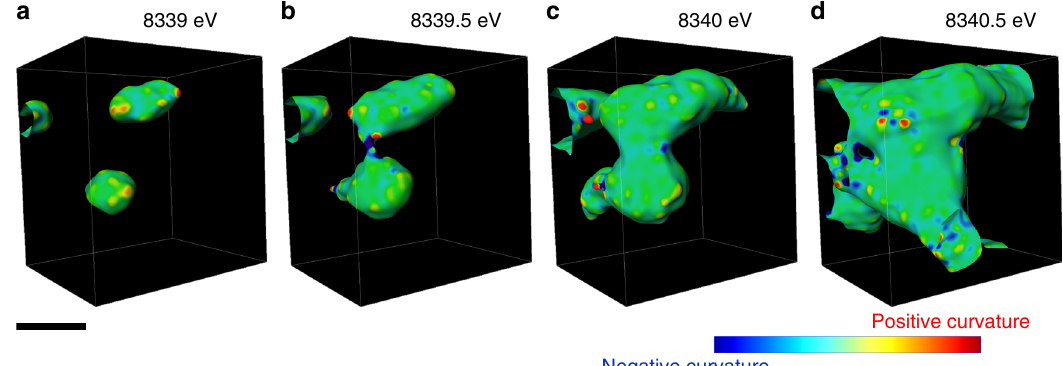
Fig. 5 Visualization of the phase front propagation at a selected localized region. The isosurface develops as thresholding Ni K-edge energy value is changed: a 8339 eV, b 8339.5 eV, c 8340 eV, and d 8340.5 eV. The evolution of the isosurface shows the propagation of the reaction front of the Ni reduction upon heating. The isosurface is color coded to the local curvature with red and blue showing positive and negative curvatures, respectively. The white arrow in ( b ) points to a neck region (see text). The scale bar is 1 μ